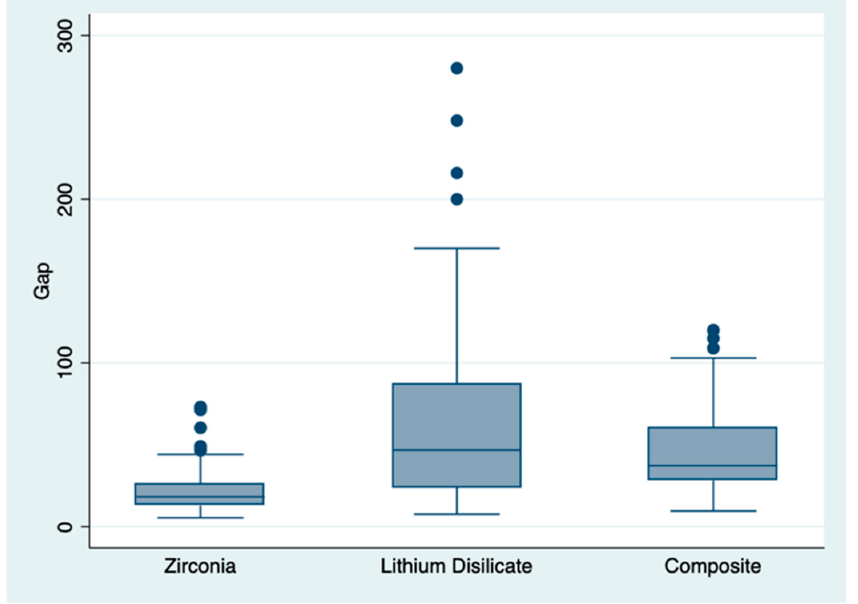
Figure 7. Boxplot representing the sample distribution. Outlier values are indicated by “ • ” symbols.